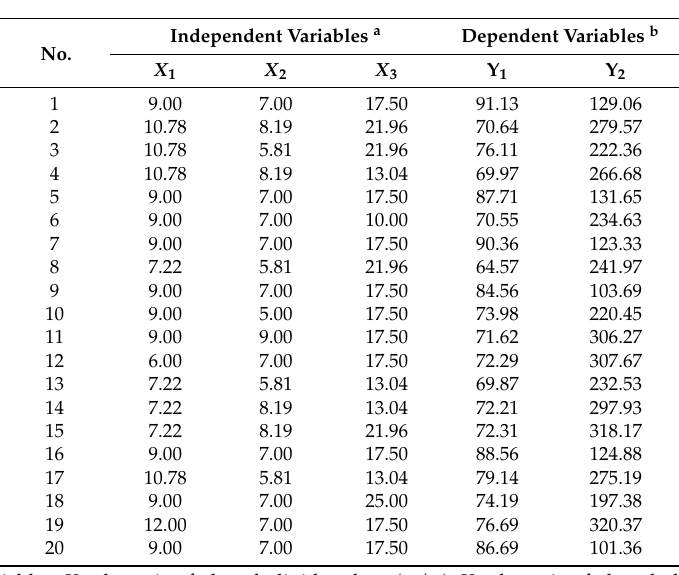
Table 1. Scheme of CCD with the results of responses on three independent factors.